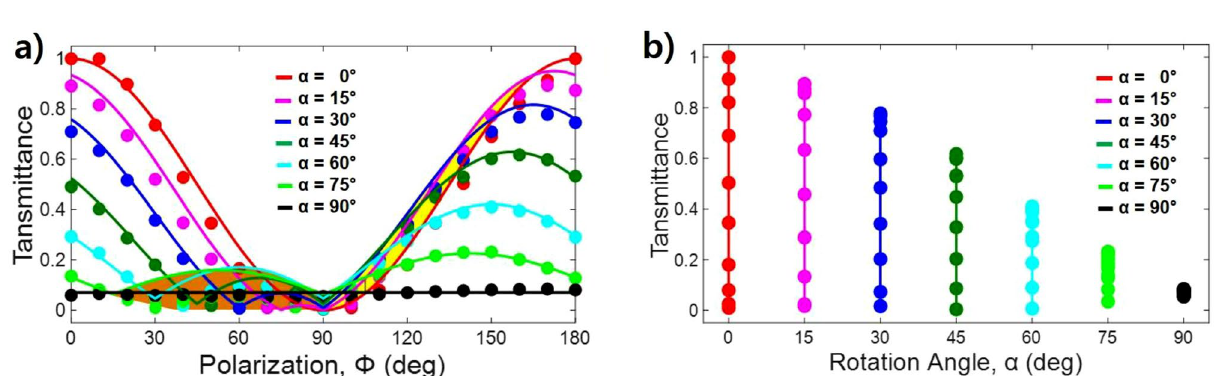
Figure 5. Characterization of the transmittance of two GMR filters. ( a ) Transmittance according to the polarization angle with different rotation angles. Dots and solid lines indicate the measured data and calculated lines by Eq. (2). The measured transmittance data has a maximum deviation of ± 0.02. ( b ) Transmittance variation according to the rotation angle. Dots indicate the measured transmittance according to each 15° rotation angle with 90° < Φ < 180° of the polarization angle. As the dot moves from the lowest to the highest position, the polarization angle increases from 90° to